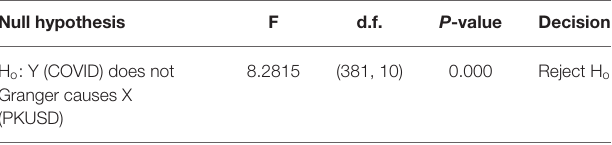
TABLE 9 | VAR granger causality test.